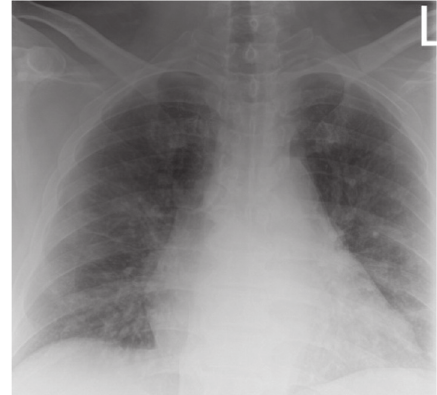
Figure 2: Chest X-ray showing multifocal patchy airspace disease,